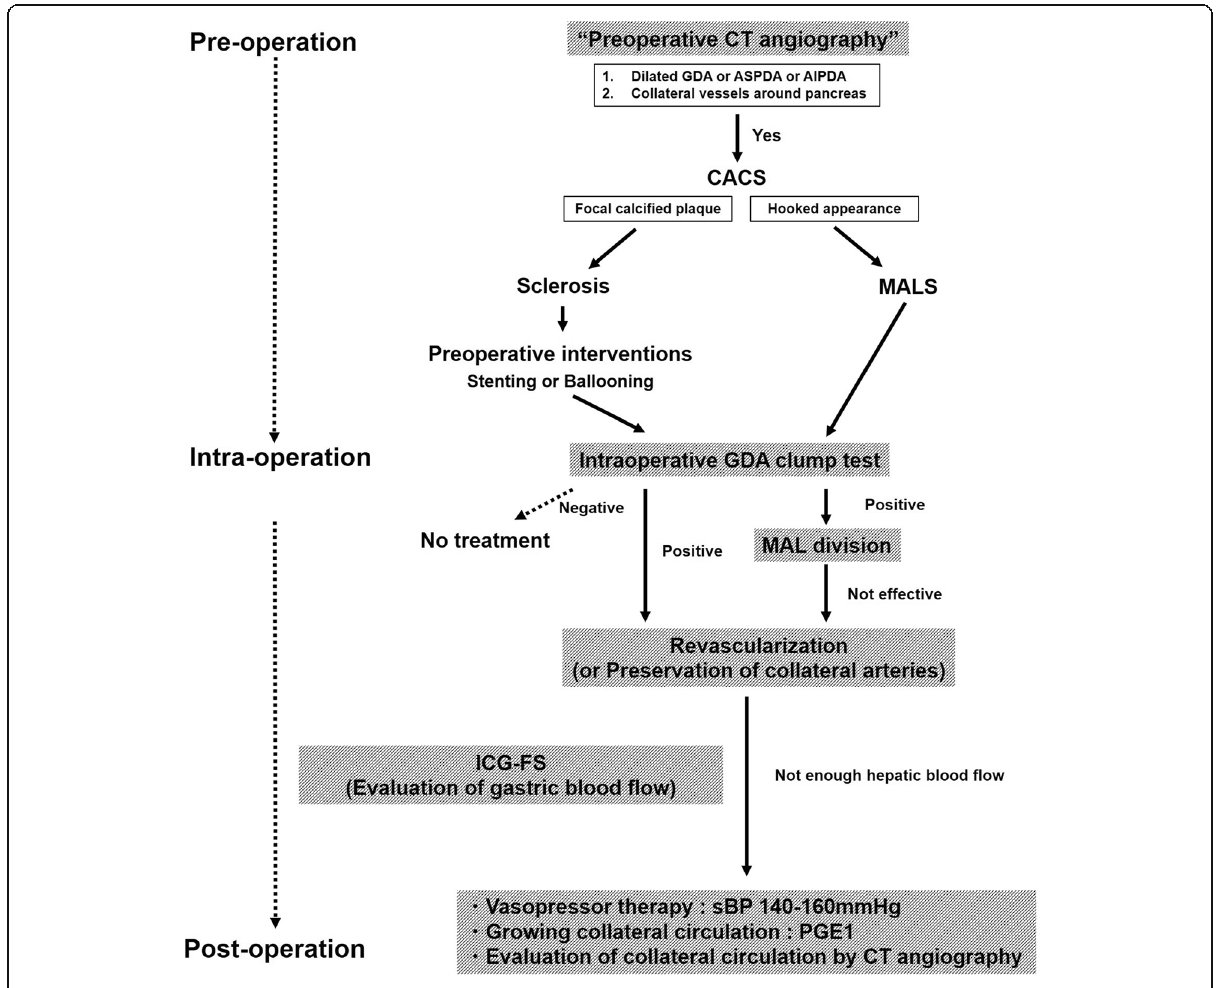
Fig. 8 The algorithm for diagnose and treatment of